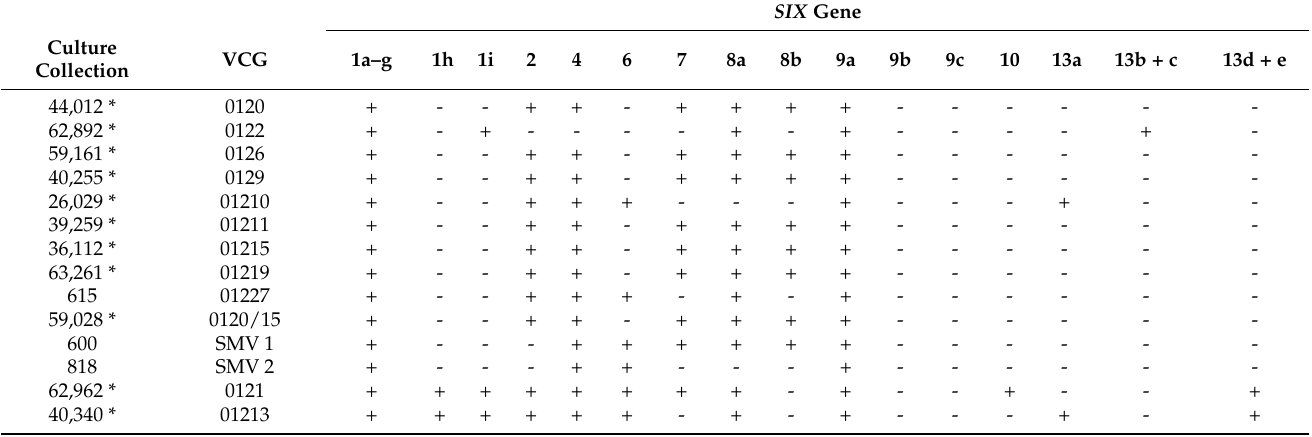
Table 2. Secreted in xylem gene distribution within different Fusarium oxysporum f. sp. cubense vegetative compatibility